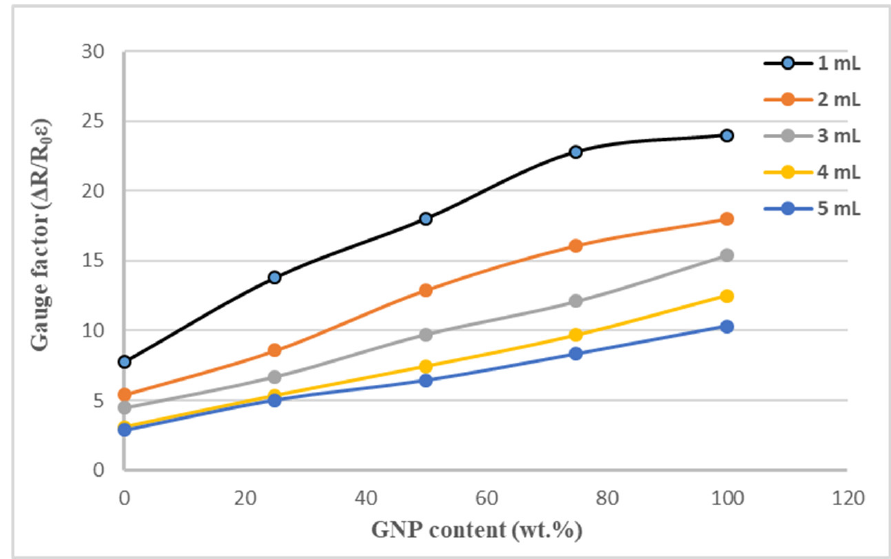
Figure 9. Gauge factor of hybrid nanomaterial film varying with spray volumes and GNP contents.